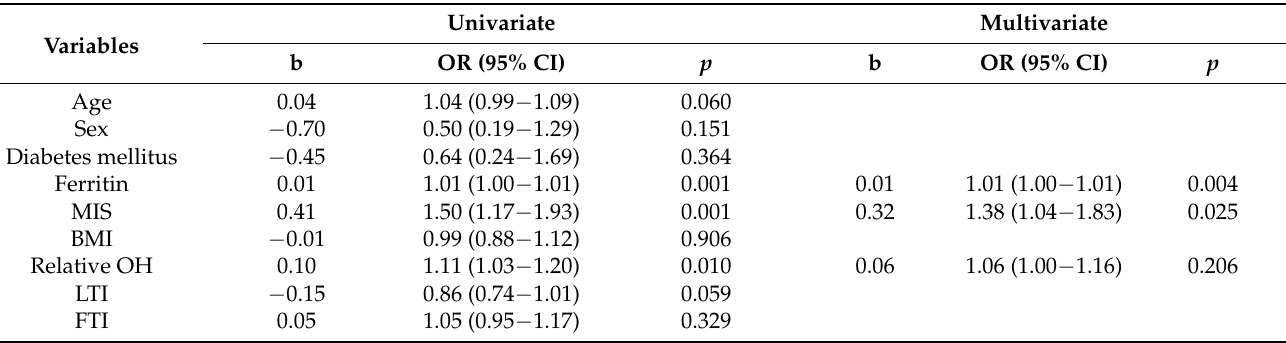
Table 3. Predictors of haemoglobin levels <10